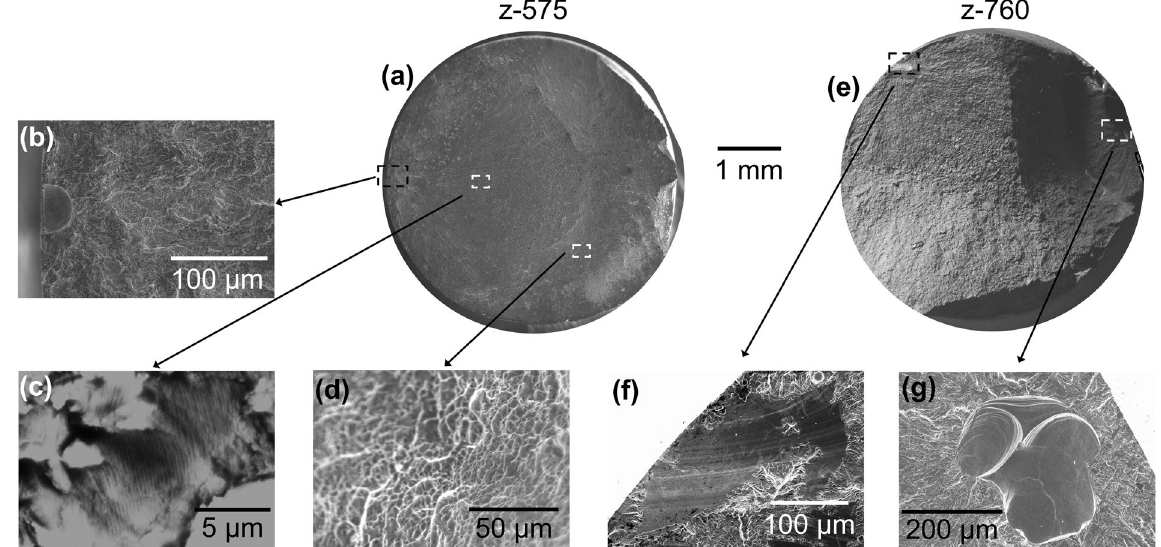
Figure 2. SEM images of example fracture surfaces - ( a ) macrograph of z-575, ( b ) crack initiation from a pore, ( c ) striations in the crack growth region, ( d ) SEM image of the fast fracture over-load region; ( e ) macrograph of z-760. ( f ) Crack initiation from a smooth facet, and ( g ) crack initiation from two conjoined gas pores.